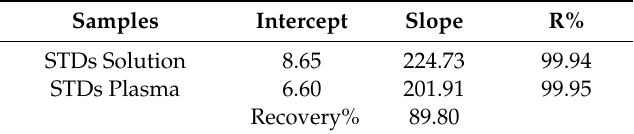
Table 2. Recovery of Galunisertib following the method of ratio of slopes between Standards (STDs) in solution and